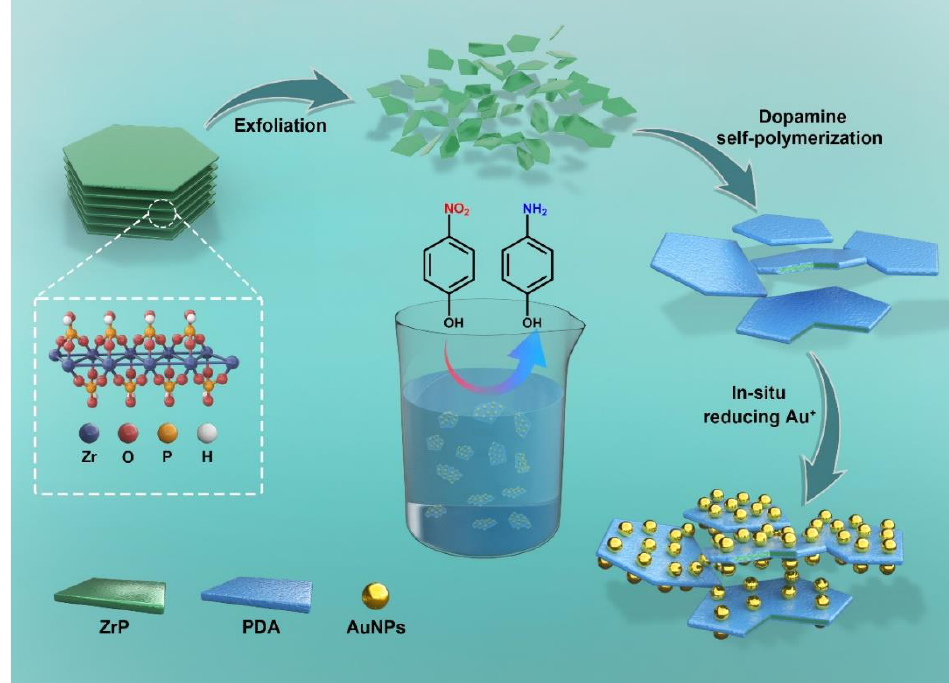
Figure 1. Schematic illustration of the preparation of the ZrP@PDA/AuNP catalyst for the conversion of 4NP to 4AP based on a mussel-inspired strategy.